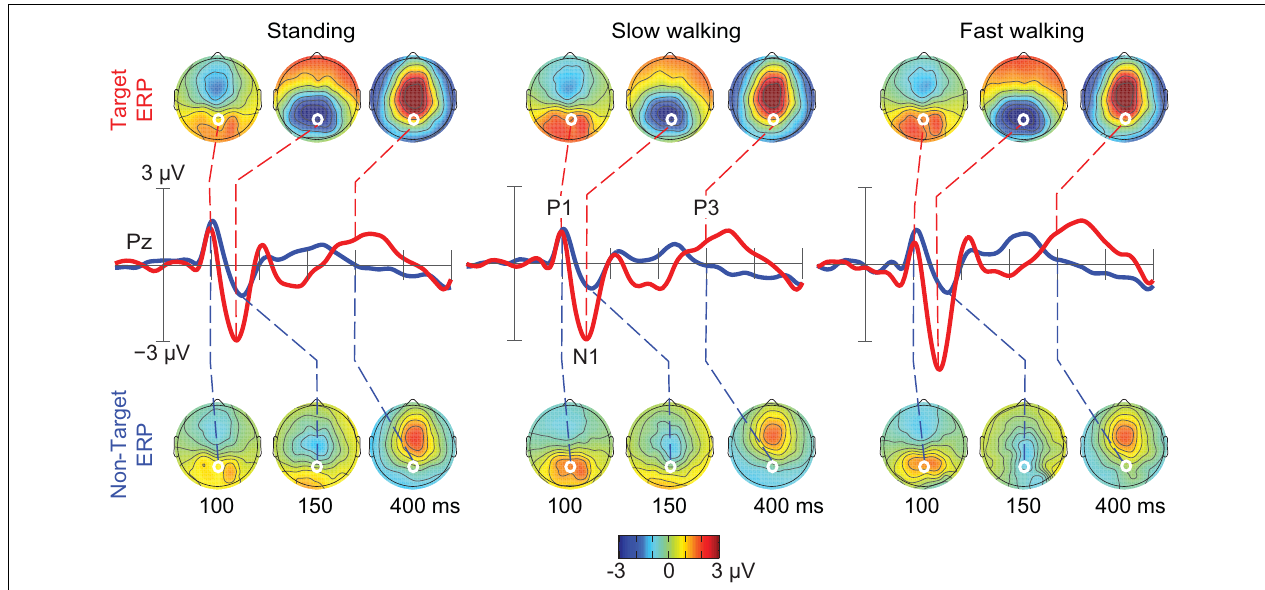
FIGURE 5 | Grand-average ERPs following ICA-based artifact removal in the standing, slow walking, and fast walking conditions. Middle-row traces show ERP time courses at electrode Pz (red, target ERPs; blue, non-target ERPs). Scalp maps show the grand-average ERP scalp distributions at 100, 150, and 400 ms after onsets of target stimuli (upper row) and non-target stimuli (lower row). White dots indicate the location of electrode Pz. Note the scalp map similarities across movement conditions.